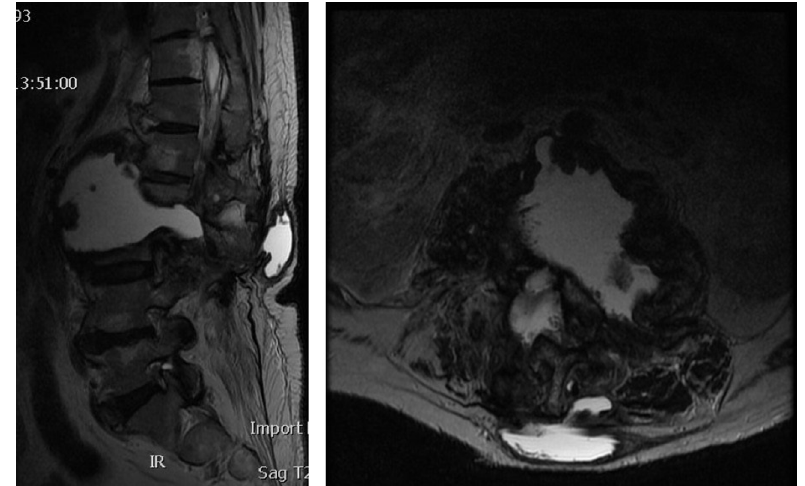
Figure 3. Pre-operative MRI in supine position showing large fl uid fi lled cavitary lesion between L2 and L3 vertebrae extending to the posterior elements and associated bony